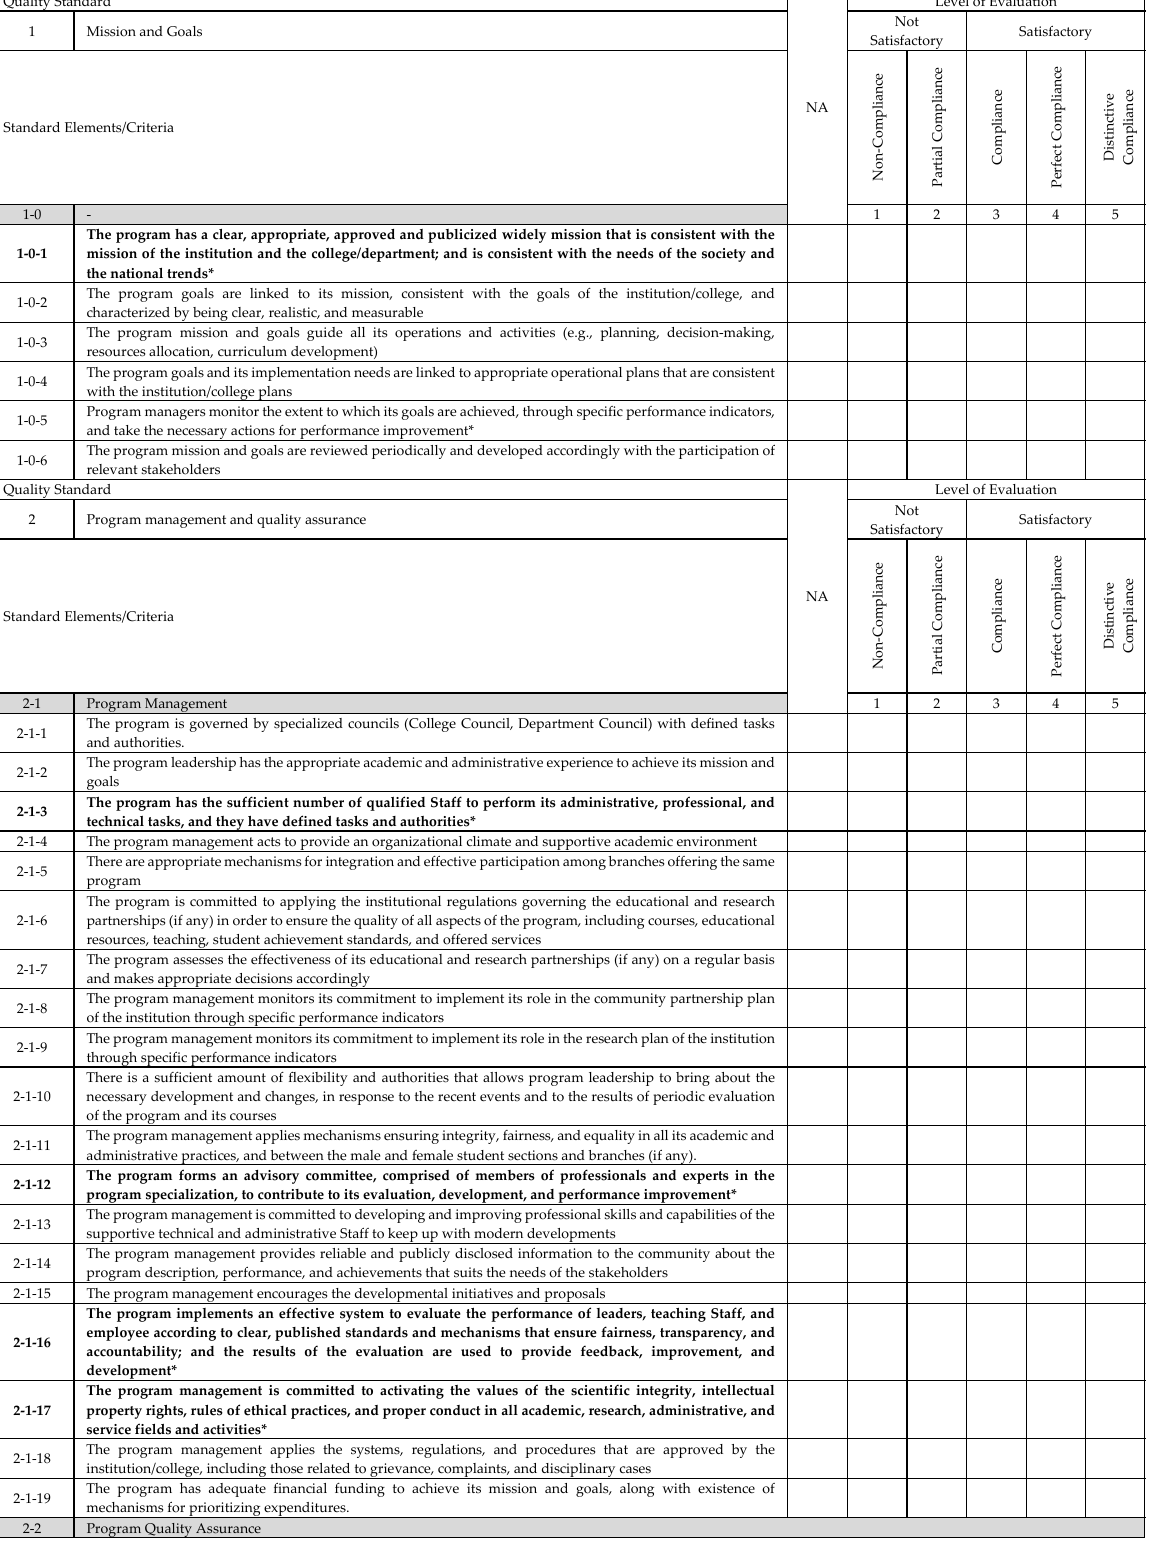
The NCAAA self-evaluation table for high educational